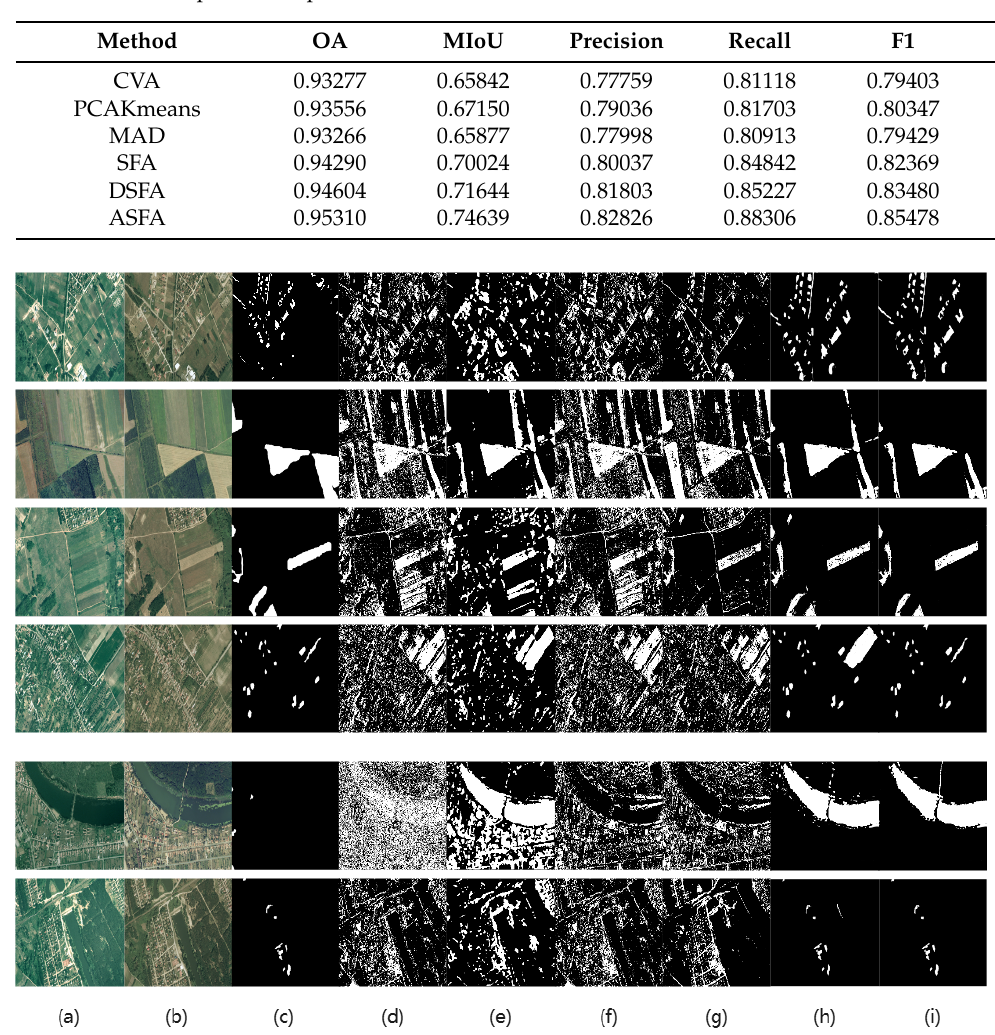
Table 11. The comparative experiment results on SZTAKI.